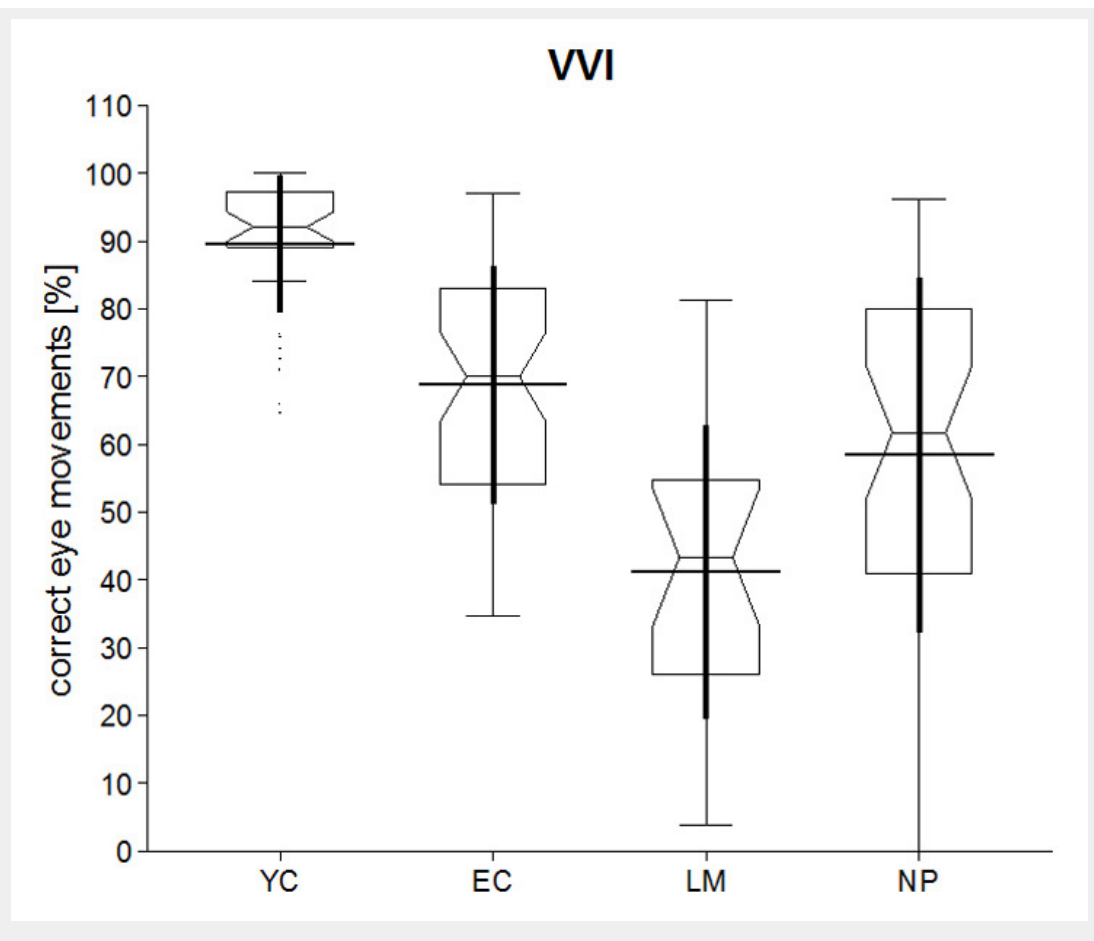
Figure 3 Evaluation of all visuovisual interactive (VVI) saccades for all groups. EC = elderly comparison group; LM = patients at the Department of Legal Medicine; NP = patients at the Department of Neurology; YC = young comparison